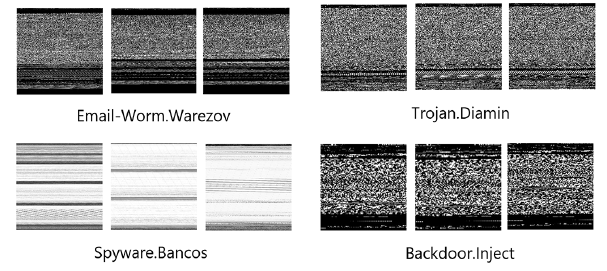
Figure 1. Some malware image examples after